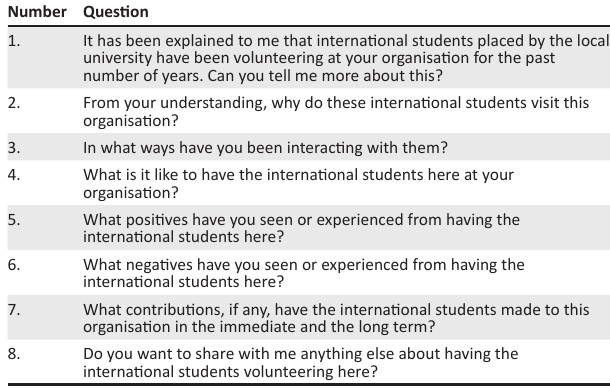
TABLE 1: Semistructured interview schedule.